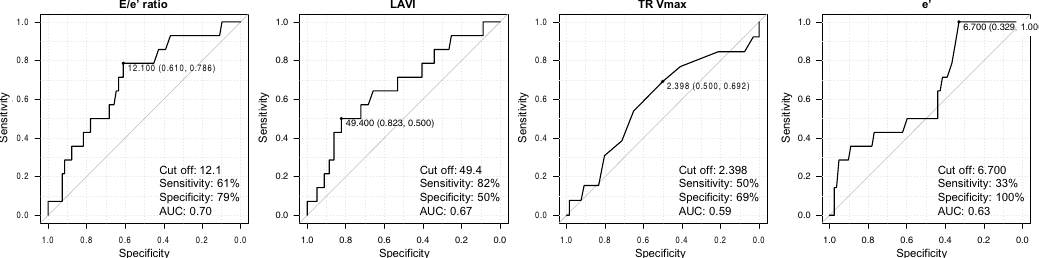
Figure 2. ROC curve of E/e ′ ratio, LAVI, TR Vmax, and e ′ at the 1-year follow-up for CV death and readmission for HF after the 1-year follow-up in patients with HFrecEF. CV cardiovascular, E/e ′ peak velocity of the early wave (E) to early diastole (e ′ ), HF heart failure, HFrecEF heart failure with recovered ejection fraction, LAVI left atrial volume index, ROC receiver operating characteristic, TR Vmax maximal tricuspid regurgitation 0.63, 95% CI 0.48–0.79, respectively; Fig. 2). There were no statistically significant differences regarding the AUC between the E/e ′ ratio and LAVI at the 1-year follow-up ( p = 0.76). Patient characteristics at discharge. Table 1 shows the patient characteristics of the study population and comorbidities at discharge. Significant differences were evident between the two groups concerning age, sex, principal cause of HF due to ischemic cardiomyopathy, and sodium, hemoglobin, and BNP levels. Regarding echocardiography during the hospitalization, LVEF and E/e ′ were higher in the HFrecEF with high E/e ′ group than the HFrecEF with low E/e ′ group. The estimated RVSP, E-wave deceleration time, e ′ , LAVI, LVMI, IVC diameter, and presence of atrial arrhythmias at the echocardiography were comparable between the two groups. Angiotensin-converting enzyme inhibitors or angiotensin receptor blocker inhibitors (ACEi/ARB) and beta- blockers were prescribed in approximately 90% of patients at discharge; statin was more often prescribed in the high E/e ′ than low E/e ′ group. Patient characteristics and echocardiography data at the 1-year follow-up. The median follow- up period between discharge and the 1-year follow-up was 365 (IQR 332–398) days. Although LVEF in both HFrecEF with low and high E/e ′ ratio groups significantly improved from 30 ± 5.5 and 33 ± 4.1% at discharge to 49 ± 6.1% and 47 ± 5.8% at the 1-year (paired-t test: p < 0.001, respectively, Fig. 1D), E/e ′ ratio in HFrecEF with high E/e ′ group were unchanged from 18 ± 6.3 at discharge to 18 ± 5.4 at the 1-year follow-up (paired-t test: p = 0.68), while E/e ′ ratio in HFrecEF with low E/e ′ group improved from 15 ± 5.4 at discharge to 8.8 ± 1.9 at the 1-year follow-up (paired-t test: p < 0.001, Fig. 1D). Interestingly, there was inversely mild correlation between the E/e ′ ratio at the 1-year follow-up and LVEF changes (%) from the discharge to the 1-year follow-up ( r = − 0.25,